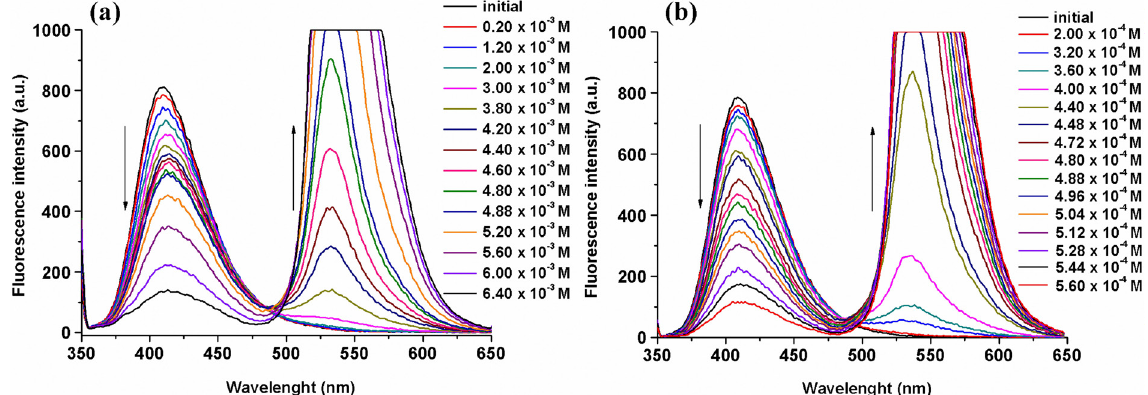
Figure 7. Fluorescence spectra of A-D-Phe- co -D-MABU-F (plot a) and A-L-Phe- co -L-MABU-F (plot b) in DMF solution, in the absence and the presence of NaOH at different concentrations; λ = 340 ex